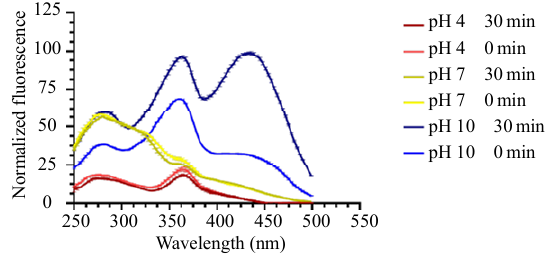
Fig. 3 Excitation spectrum of ThiAKS Green at pH 4, 7, and 10 and the emission wavelength at 540